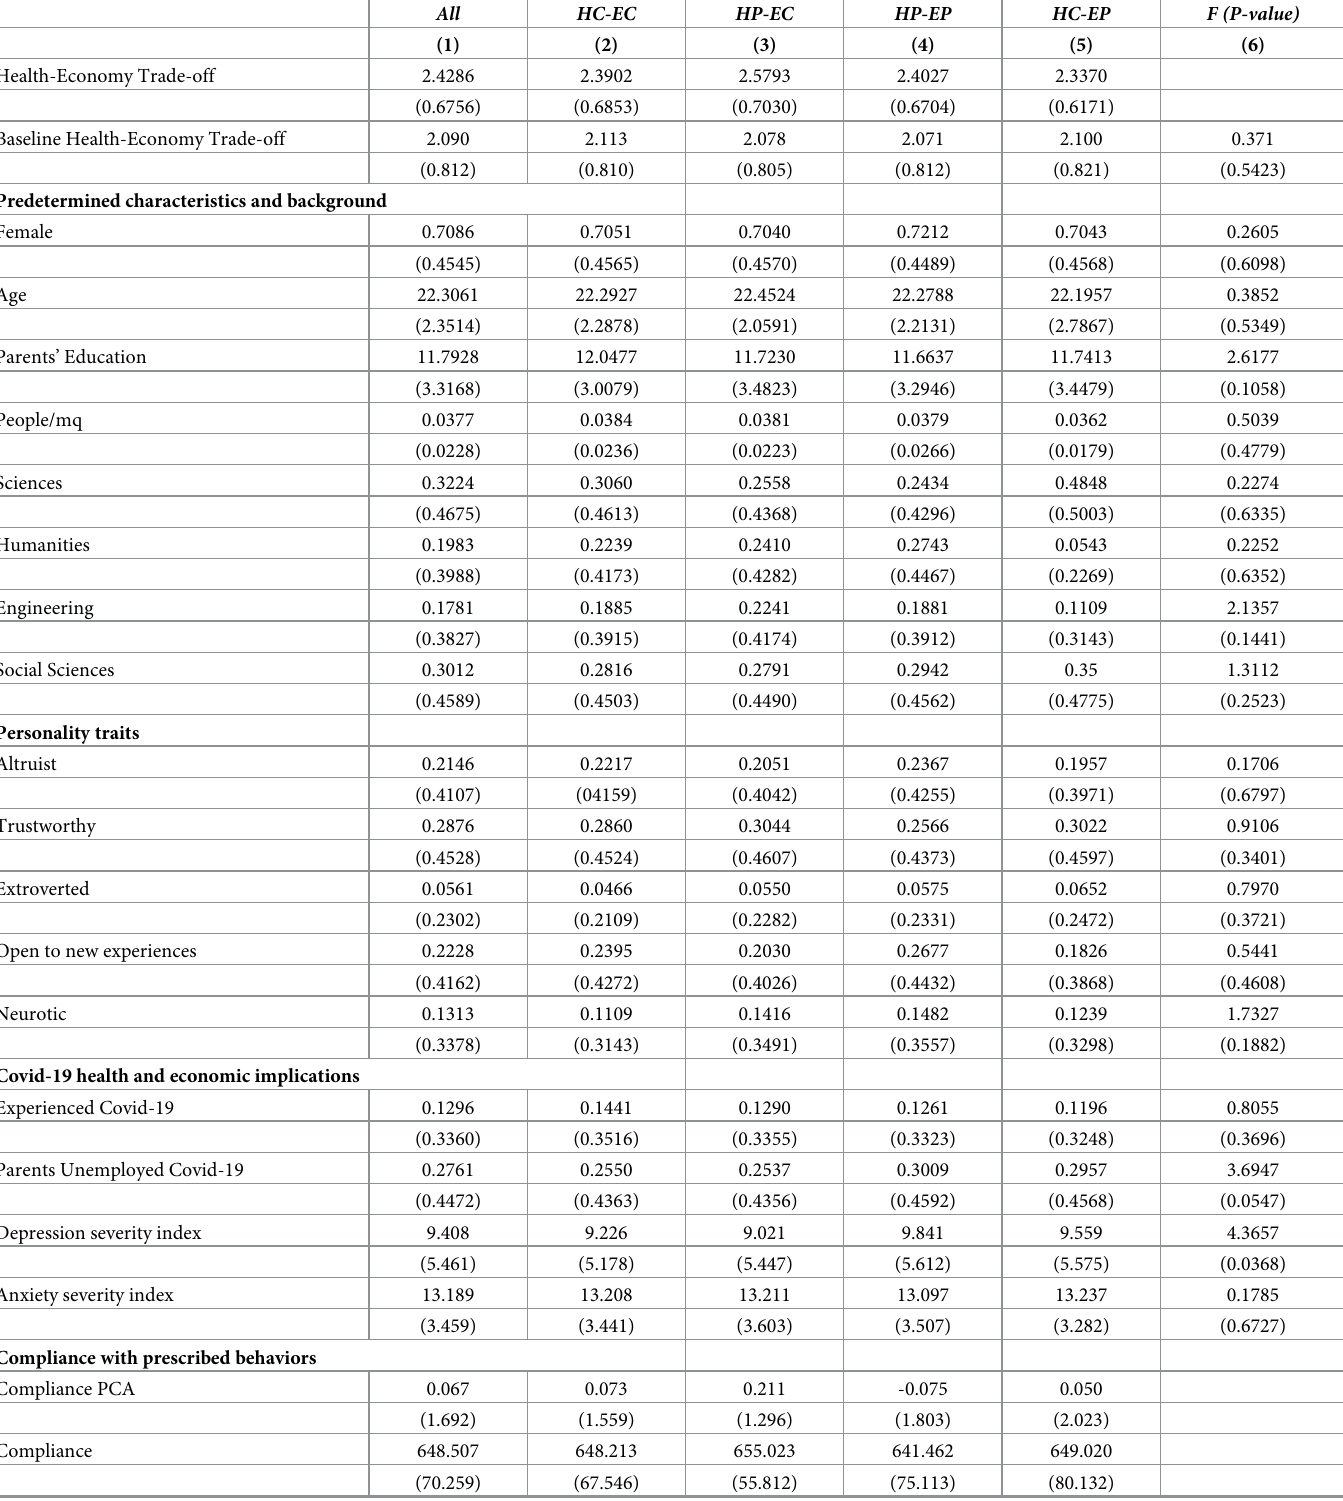
Table 2. Descriptive